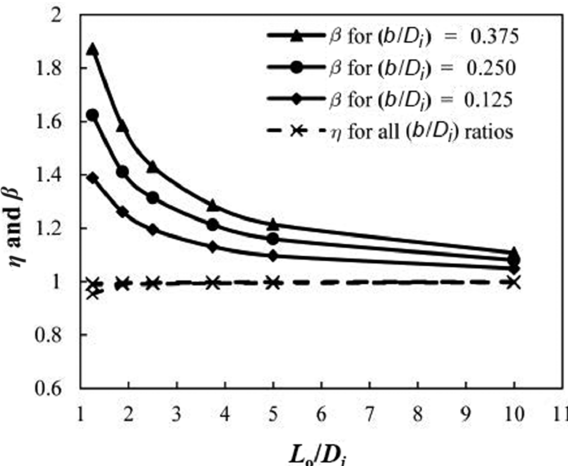
Figure 8: Variations of β and η parameters with various b / D i ratios; the ratio k / D i for the specimens was 2 for all